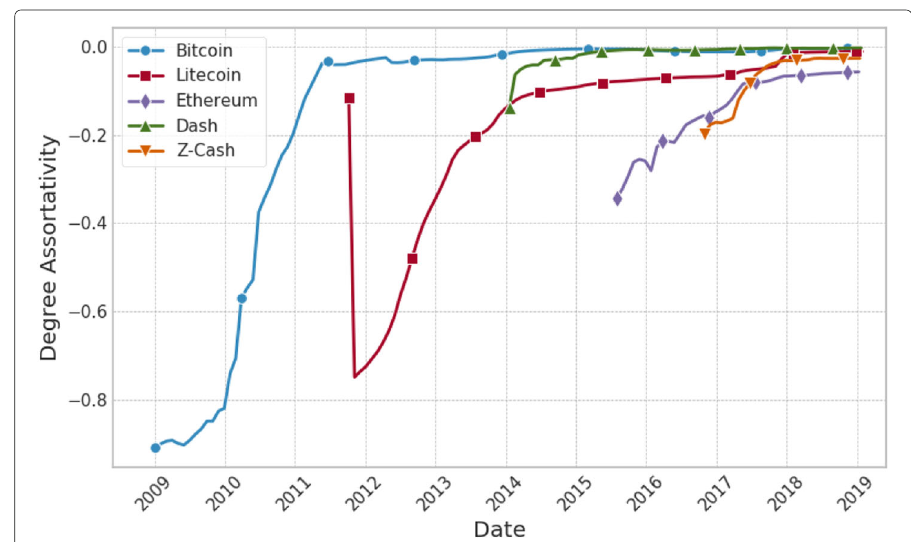
Fig. 11 Degree assortativity in CMTG